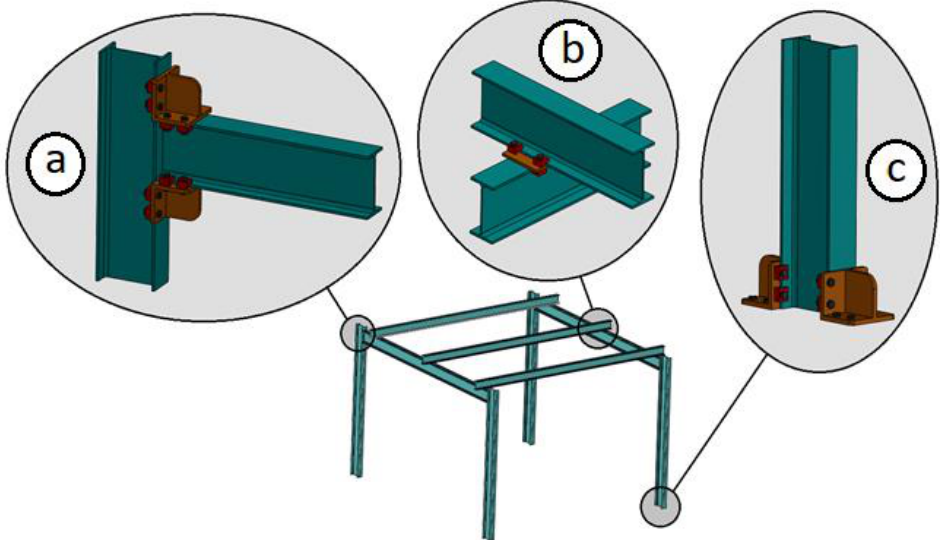
Figure 1. Example of different joints made with clamps: ( a ) joint of the beams end at 90° with a column; ( b ) joint of cross-joining between the flanges of the profiles; ( c ) removable base system for supports of I-type profile.